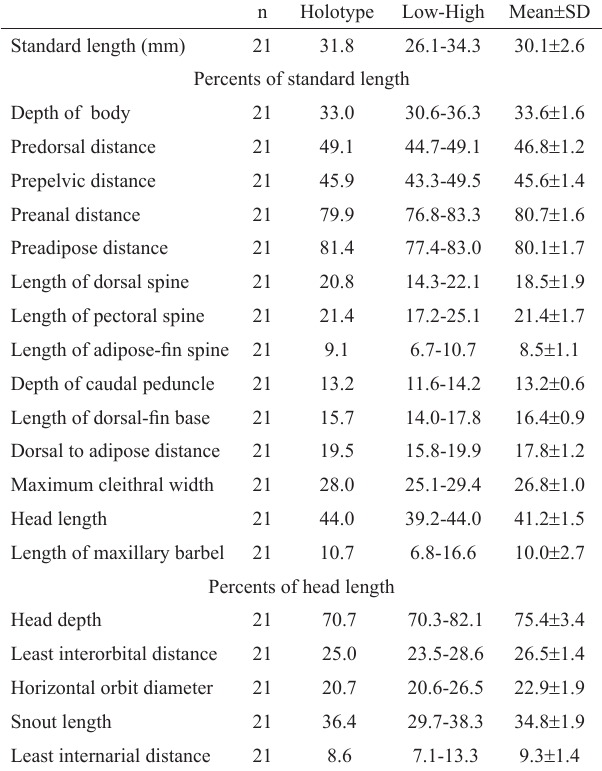
Tabela 1. Morphometric data of Corydoras lacrimostigmata . n = number of specimens and SD = standard deviation.